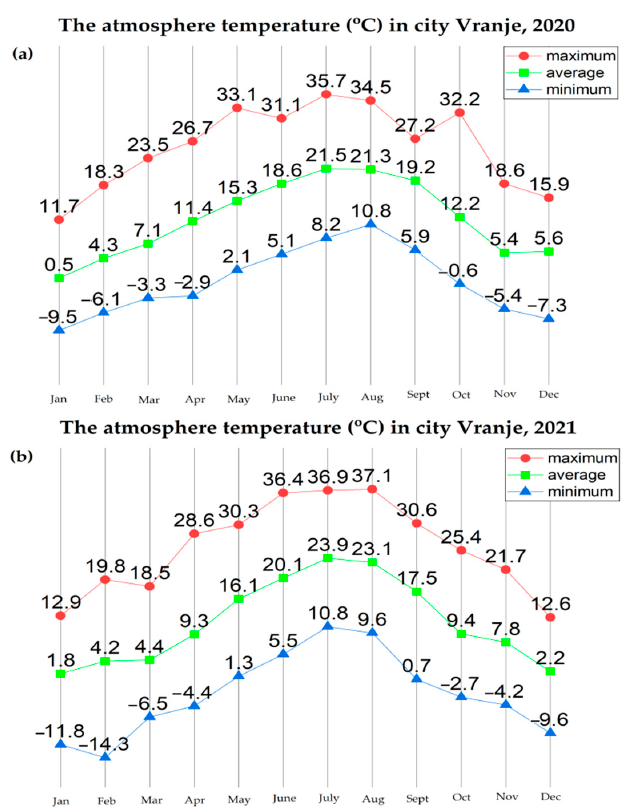
Figure 13. The atmosphere temperature in Vranje, in different months during: ( a ) 2020 and ( b )